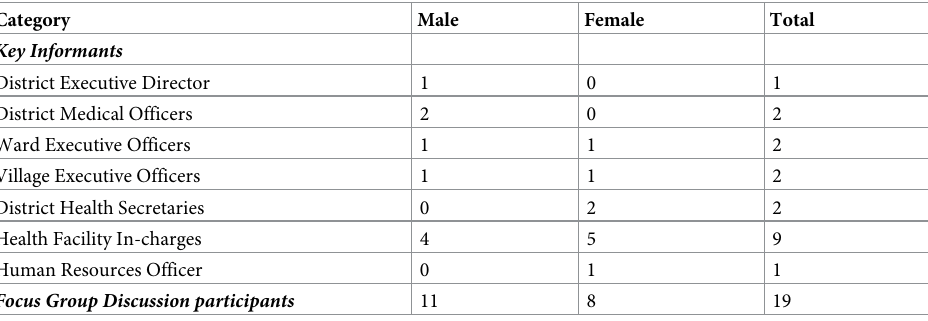
Table 2. Participants for KIIs and